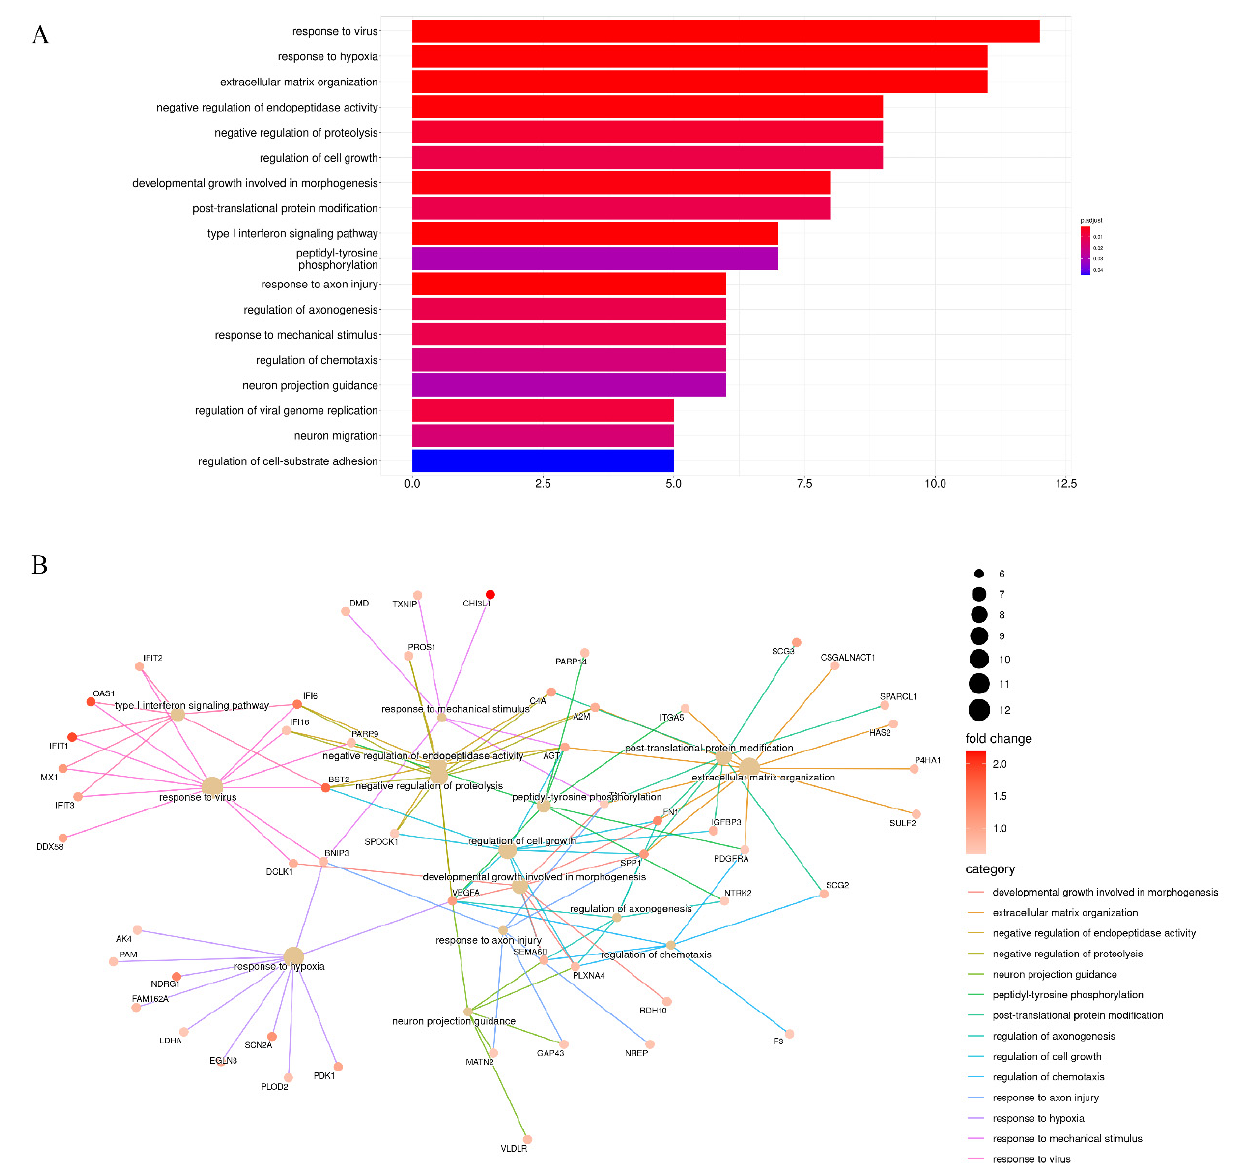
Figure 2. Enriched GO terms for up − regulated stiffness − dependent genes. ( A ) Most enriched GO terms of up − regulated genes. ( B ) Correlation gene networks of up − regulated genes.